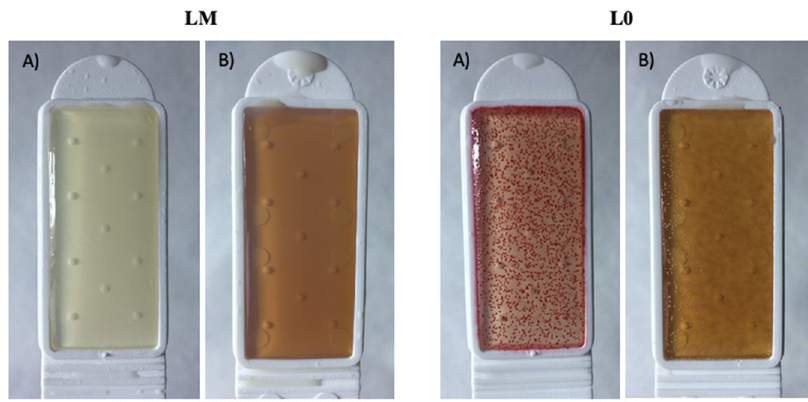
Figure 1. Results of In-Can Stability Testing of Aqueous Polymer Dispersions: ( A ) Bacteria, ( B ) Mold and/or Yeast.